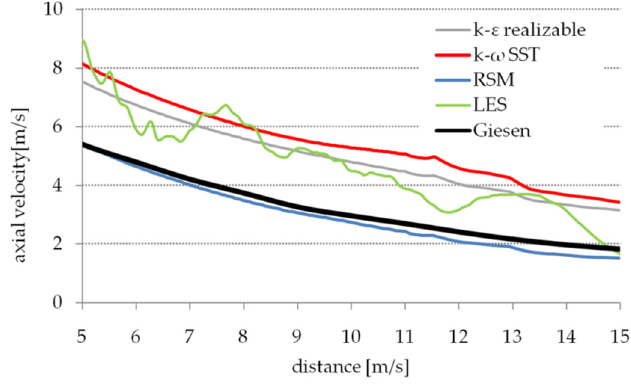
Figure 7. Axial velocity distributions for ( a ) free jet, ( b ) wall jet obtained with selected turbulence models.